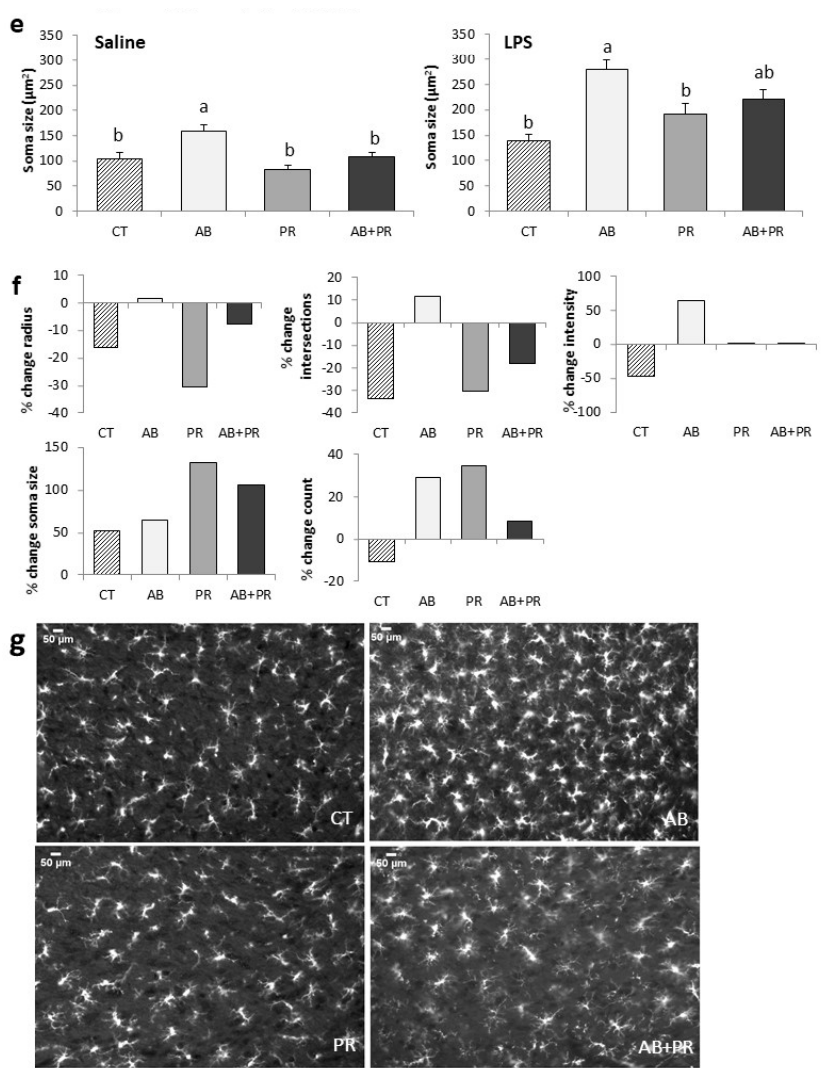
Figure 5. In the PVN ( a ) average length of longest process in saline- and LPS-injected rats; ( b ) average number of intersections as determined by Sholl analysis in saline- and LPS-injected rats; ( c ) cell count per 1.77 m 2 in saline- and LPS-injected rats; ( d ) fluorescent intensity as assessed by mean grey value in saline- and LPS-injected rats; ( e ) average soma size ( µ m 2 ) in saline- and LPS-injected rats; ( f ) average percent change in radius, intersections, cell count, intensity, and soma size in LPS- compared to saline-injected animals (means only); ( g ) representative images of LPS-injected immunofluorescent Iba-1 microglia under fluorescent microscopy in the PVN of the hypothalamus. Scale bars = 50 µ m. Values are mean ± SEM ( n = 3–6 / group). Post hoc analysis is depicted with the superscripts a,b where groups without a common superscript di ff er ( p < 0.05) (i.e., a is di ff erent from b but ab is not di ff erent from a or b). CT: control; AB: antibiotic; PR: prebiotic; AB + PR: antibiotic plus